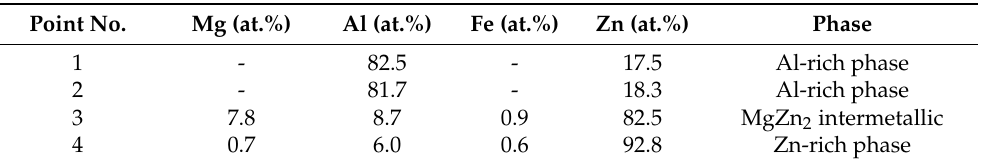
Figure 1. SEM images of the ZAMS coating: ( a ) cross-sectional microstructures and ( b ) Al-rich dendrites and Zn/MgZn 2 eutectics in the outer layer. Table 3. Results of the EDS analysis of the outer layer of coatings and the corresponding phase (analysis points as shown in Figure 1b).